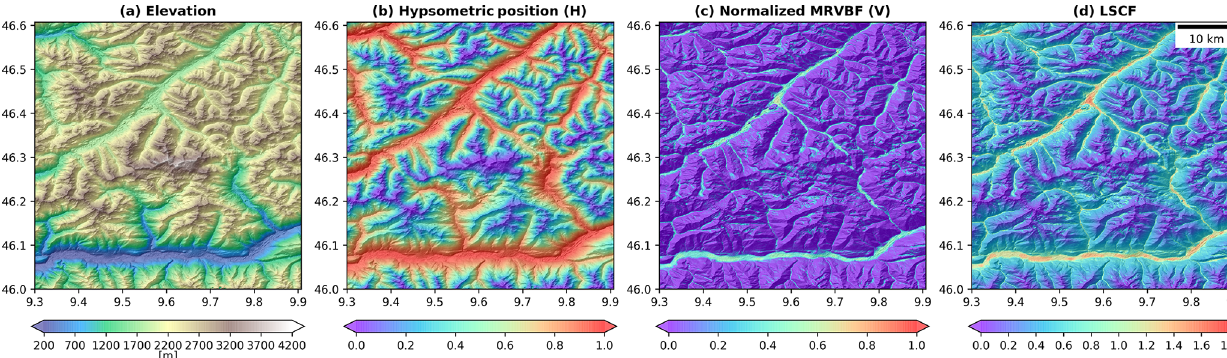
Figure 9. Spatial variation of elevation (a) , hypsometric position (b) , normalized MRVBF (c) and LSCF (d) in selected slope